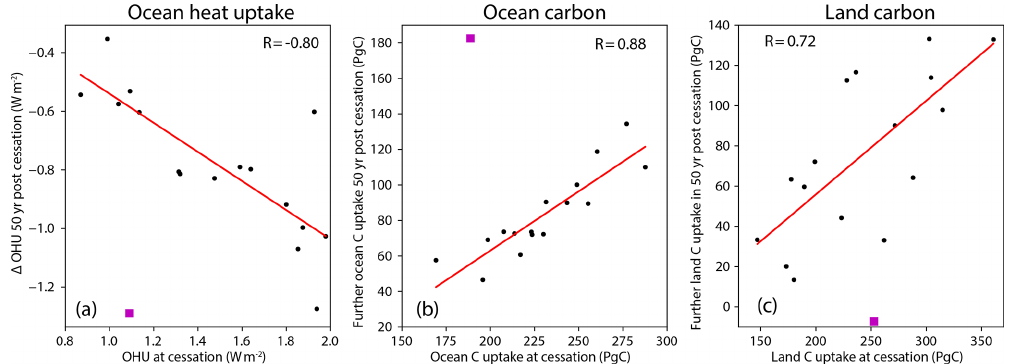
Figure 9. Relationship between variables before emissions cease and 50 years after emissions cease. (a) Ocean heat uptake (OHU) is computed for 20-year windows with the value at cessation taken from the 1pctCO2 experiment in a way analogous to the how temperature of cessation is computed. (b) Cumulative ocean carbon uptake and (c) Cumulative land carbon uptake are shown. Each marker represents a value from a single model. The line of best fit excludes the outlier model IAPRAS, which is marked with a magenta square.